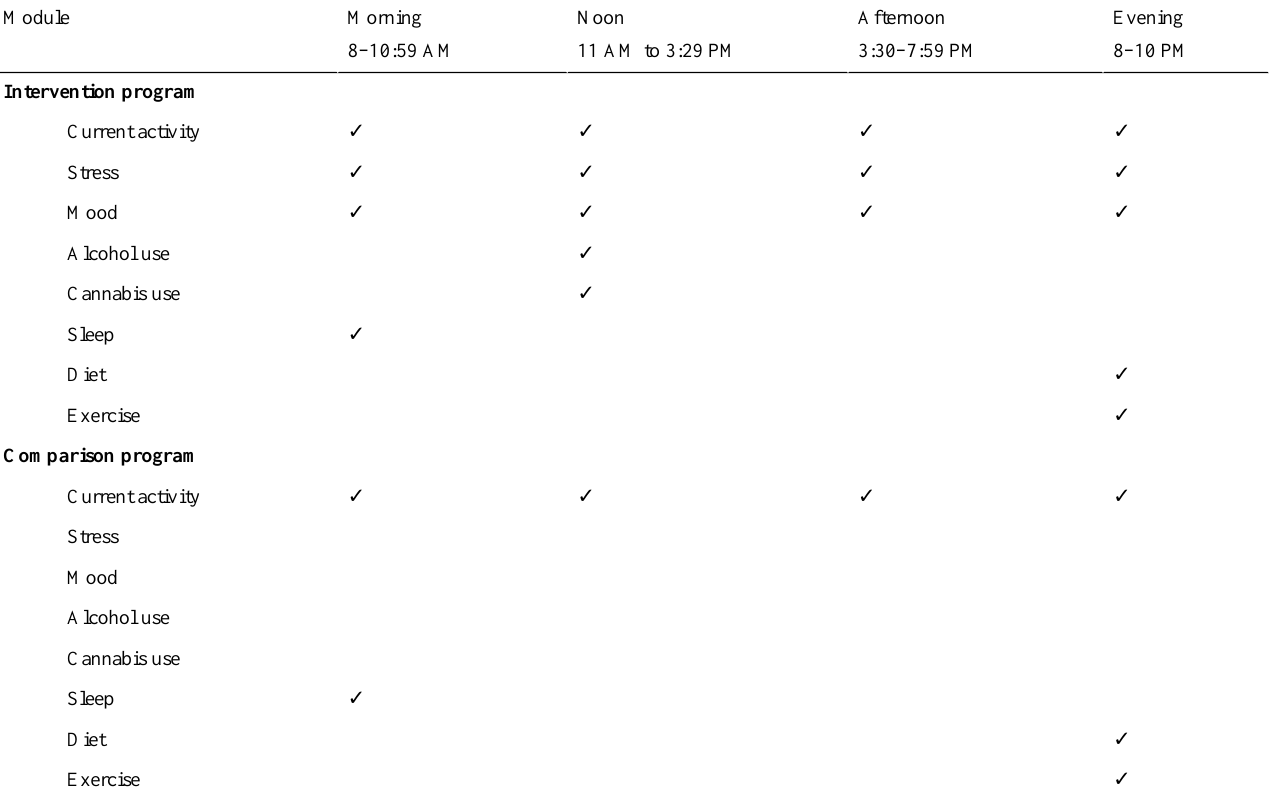
Table 1. Modules included in each block of the mobiletype comparison and intervention programs.